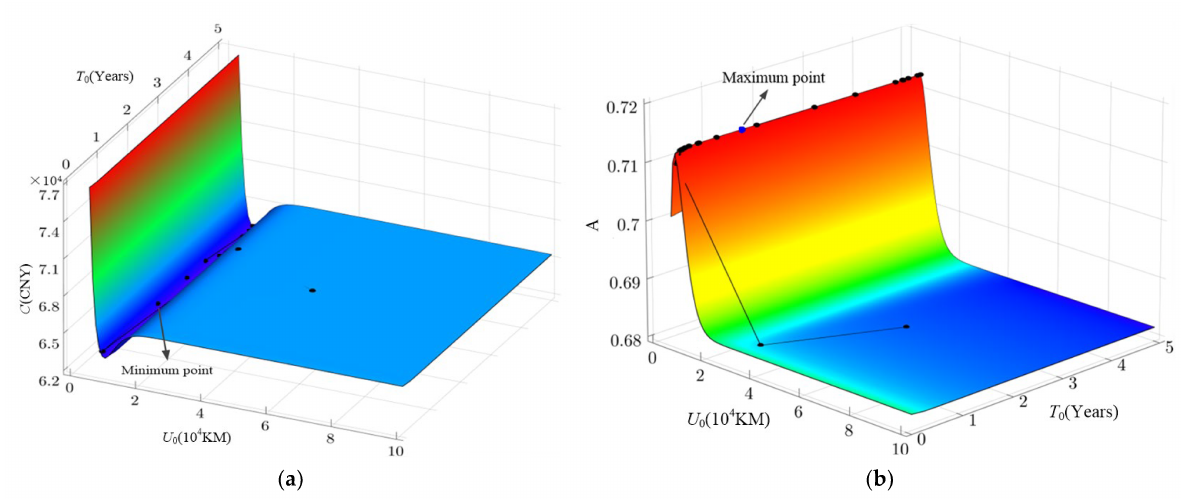
Figure 9. Algorithm iteration diagram. ( a ) Changes in warranty cost, ( b ) Changes in